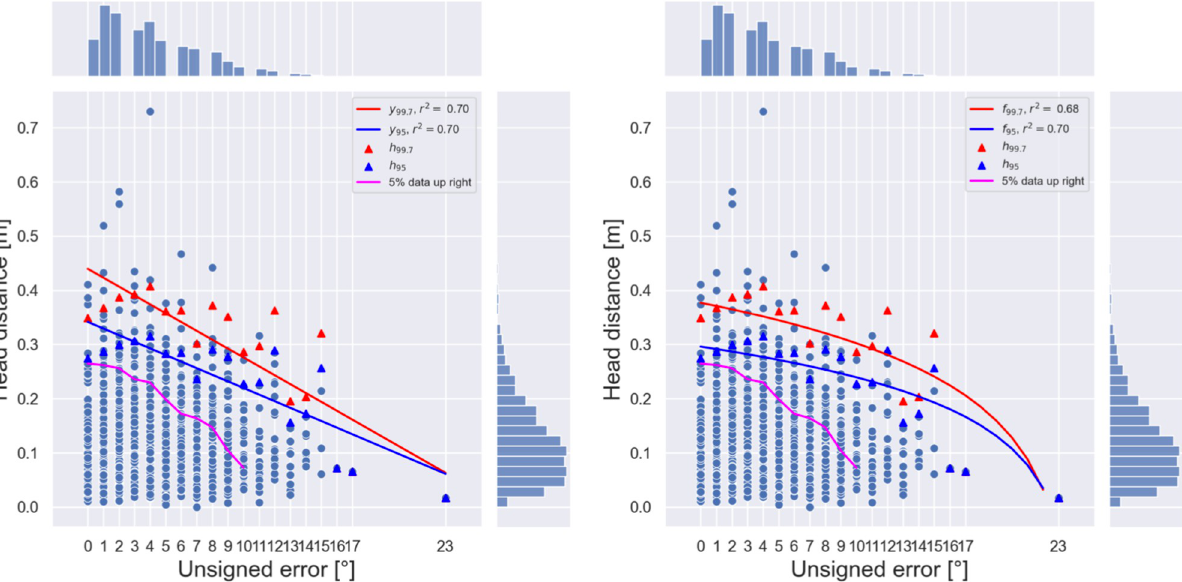
Fig 7. Head distance as a mapping of the aggregated unsigned error for group G ( V ) in condition V. Each dot indicates, respectively, the outcome of a single trial. Overlaid are the linear and logarithmic regression curves fitted to the 95% (blue) and 99.7% (red) confidence interval upper bounds, and the set of data points partitioning the plane in such a way that 5% of the entries are left in the upper-right quadrant cornered by the respective point (magenta). Each point on the “5% data up right” line is defined so that, taking that point as a lower left corner, the corresponding upper right quadrant contains 5% of the total number of data points.